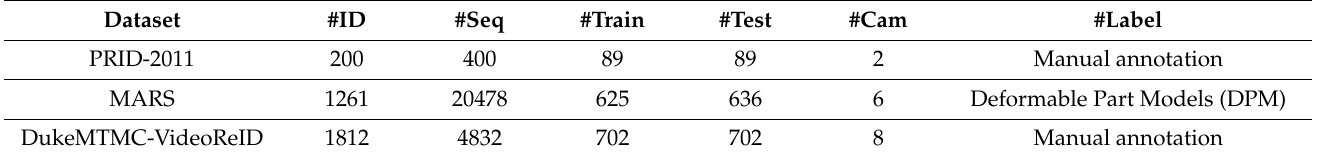
Table 1. Statistics of video datasets.